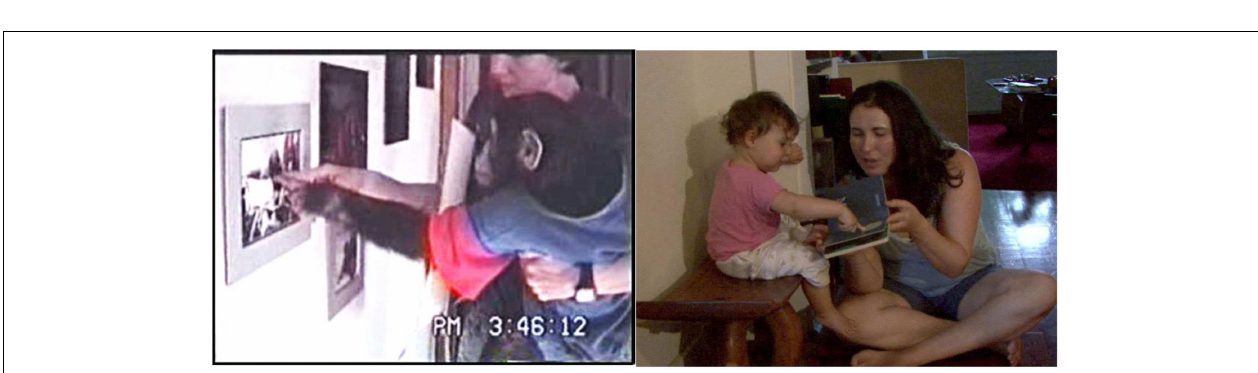
walked to it, and Panpanzee (22months, 20days) point-touched it. Sue then also point-touched it and commented on the picture. Right: human example – Mom is reading book to GN (12months, 6days). GN gestures toward it, then point-touches moon in it. “Look, there’s the moon,” says Mom.